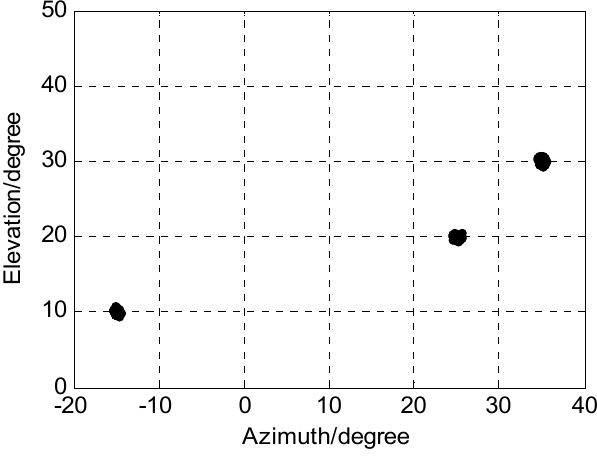
Figure 2. Angle estimation of our algorithm for ULA in SNR = 15 dB ( M = 12, J = 100, and K = 3).